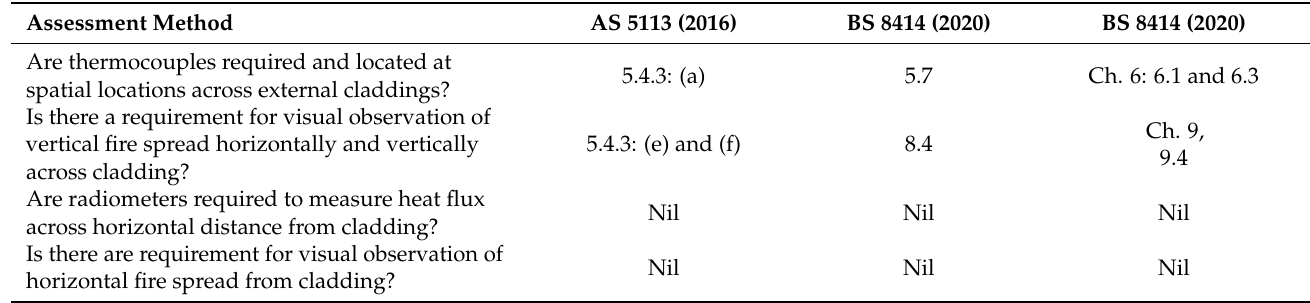
Table 1. Assessment Methods for Each Cladding Standard (sections/chapters for each standard addressing assessment methods